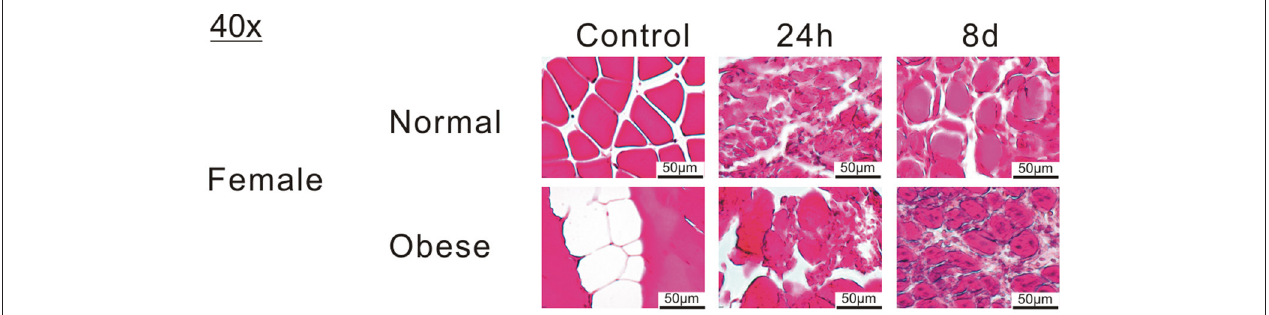
FIGURE 2 | Hematoxylin-eosin (HE) staining of muscle tissue sections from female normal weight and obese mice for control, 24h and 8 d after blunt injury induction. Muscle damage and myofiber regeneration are visible. Pictures were taken with Olympus IX81 using Xcellence v.1.2. Scale = 50 µ m at 40x magnification.